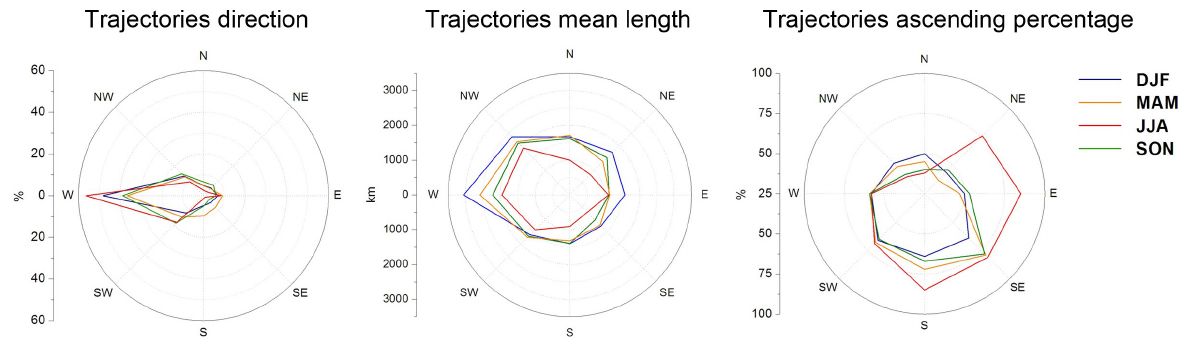
Fig. 5. Summary of seasonal characteristics of air mass back-trajectories, calculated using the NOAA HYSPLIT model, in the three years 2007–2009 time period (DJF: December, January, February; MAM: March, April, May; JJA: June, July, August; SON: September, October, November).